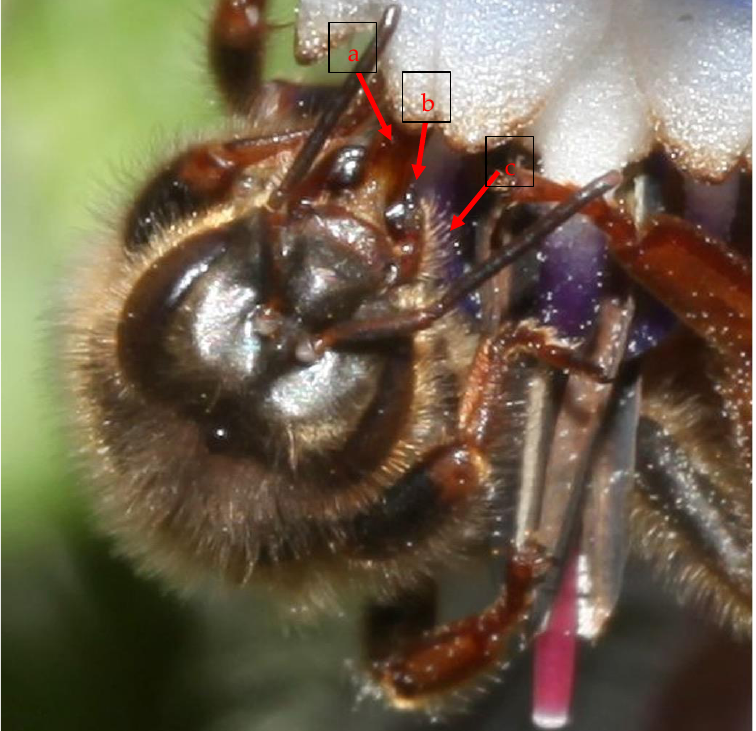
Figure 2. Morphological details of the mouthparts of the observed queen bee: ( a ) extended proboscis; Figure 2 . Morphological details of the mouthparts of the observed queen bee: a - extended proboscis; b - bilobed shape ( b ) bilobed shape of the mandible with the outer lobe toothlike; ( c ) long hairs on the outer surface of of the mandible with the outer lobe toothlike; c - long hairs on the outer surface of the mandibles (Uri, Sardinia, Italy; the mandibles (Uri, Sardinia, Italy; photo: Pietro photo: Pietro Niolu).